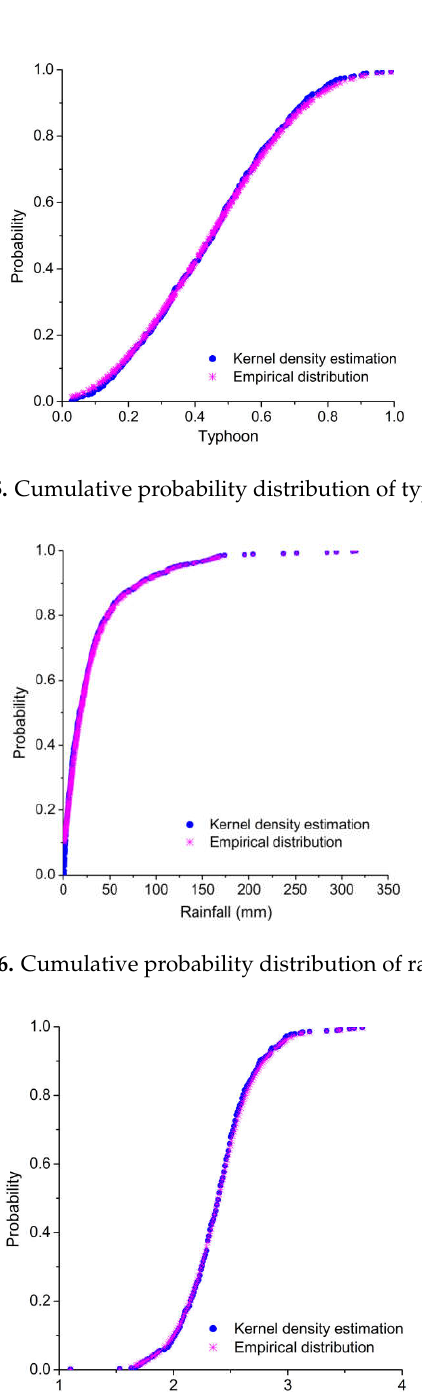
Table 7. Fitting results of trivariate distribution functions.